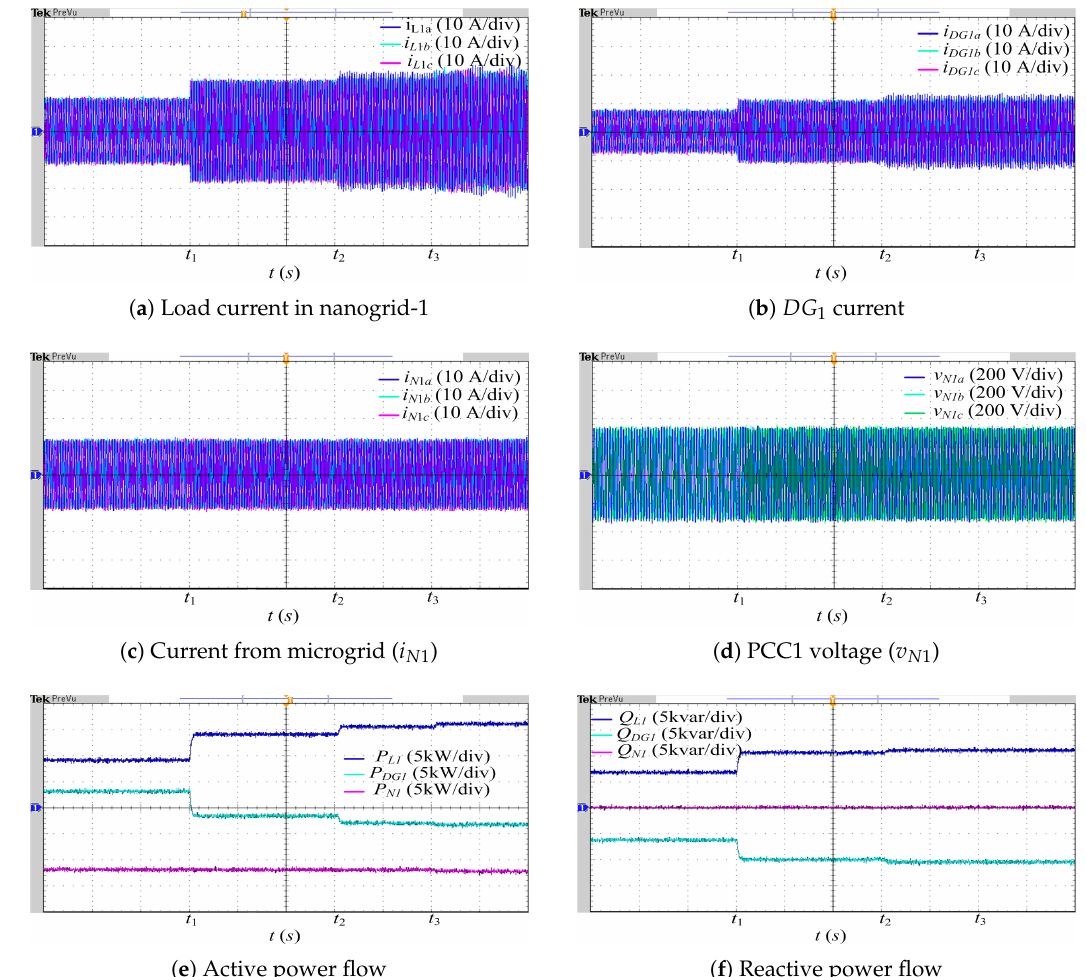
Figure 6. Current waveforms, PCC1 voltage and power flow curves in nanogrid-1.